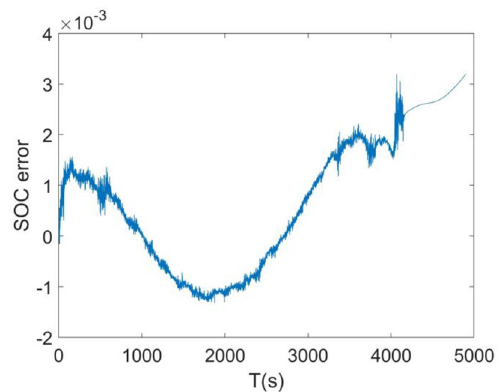
Figure 13 SOC estimation